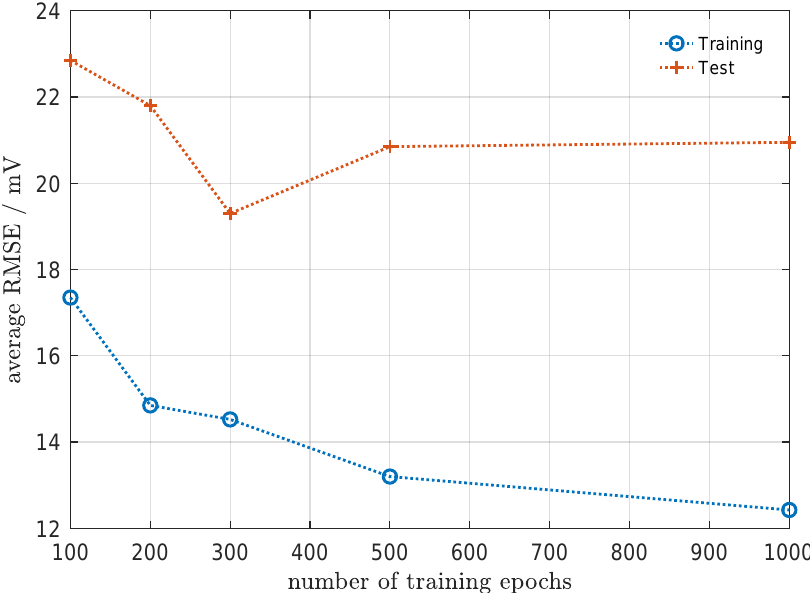
Figure 5. Average training and test losses as a function of the number of training epochs in the first training